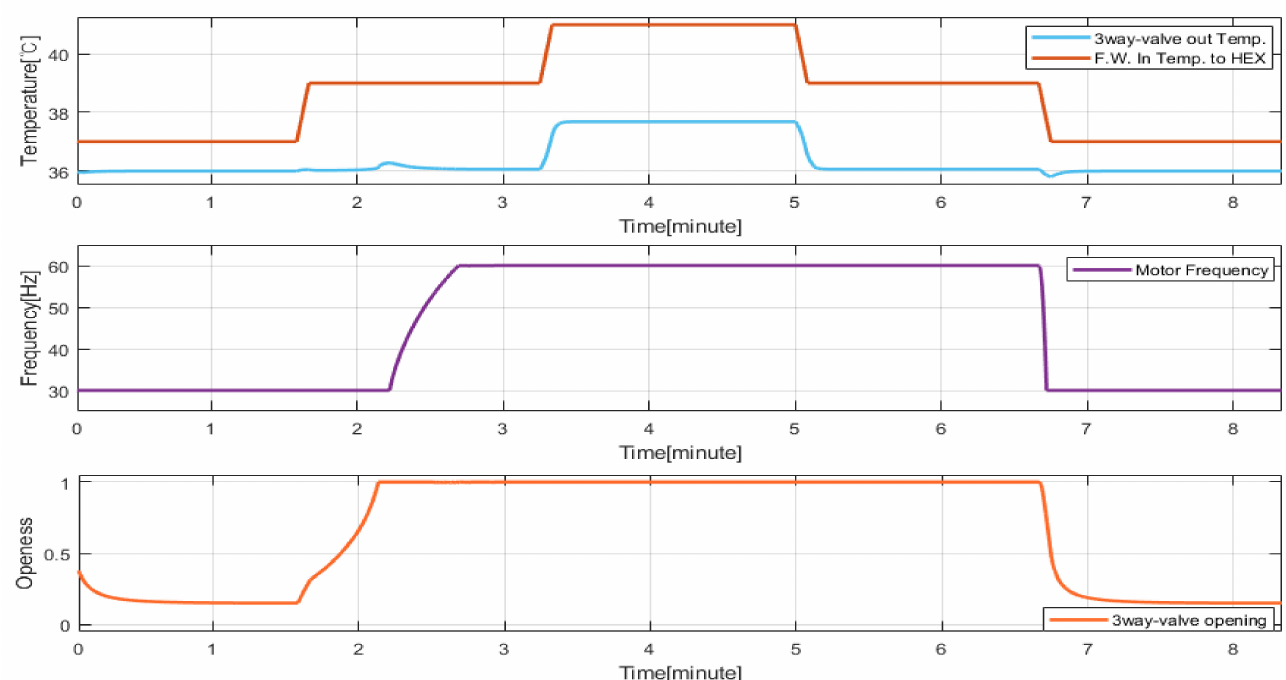
Figure 20. The simulation result graph for separated feed-back signals.